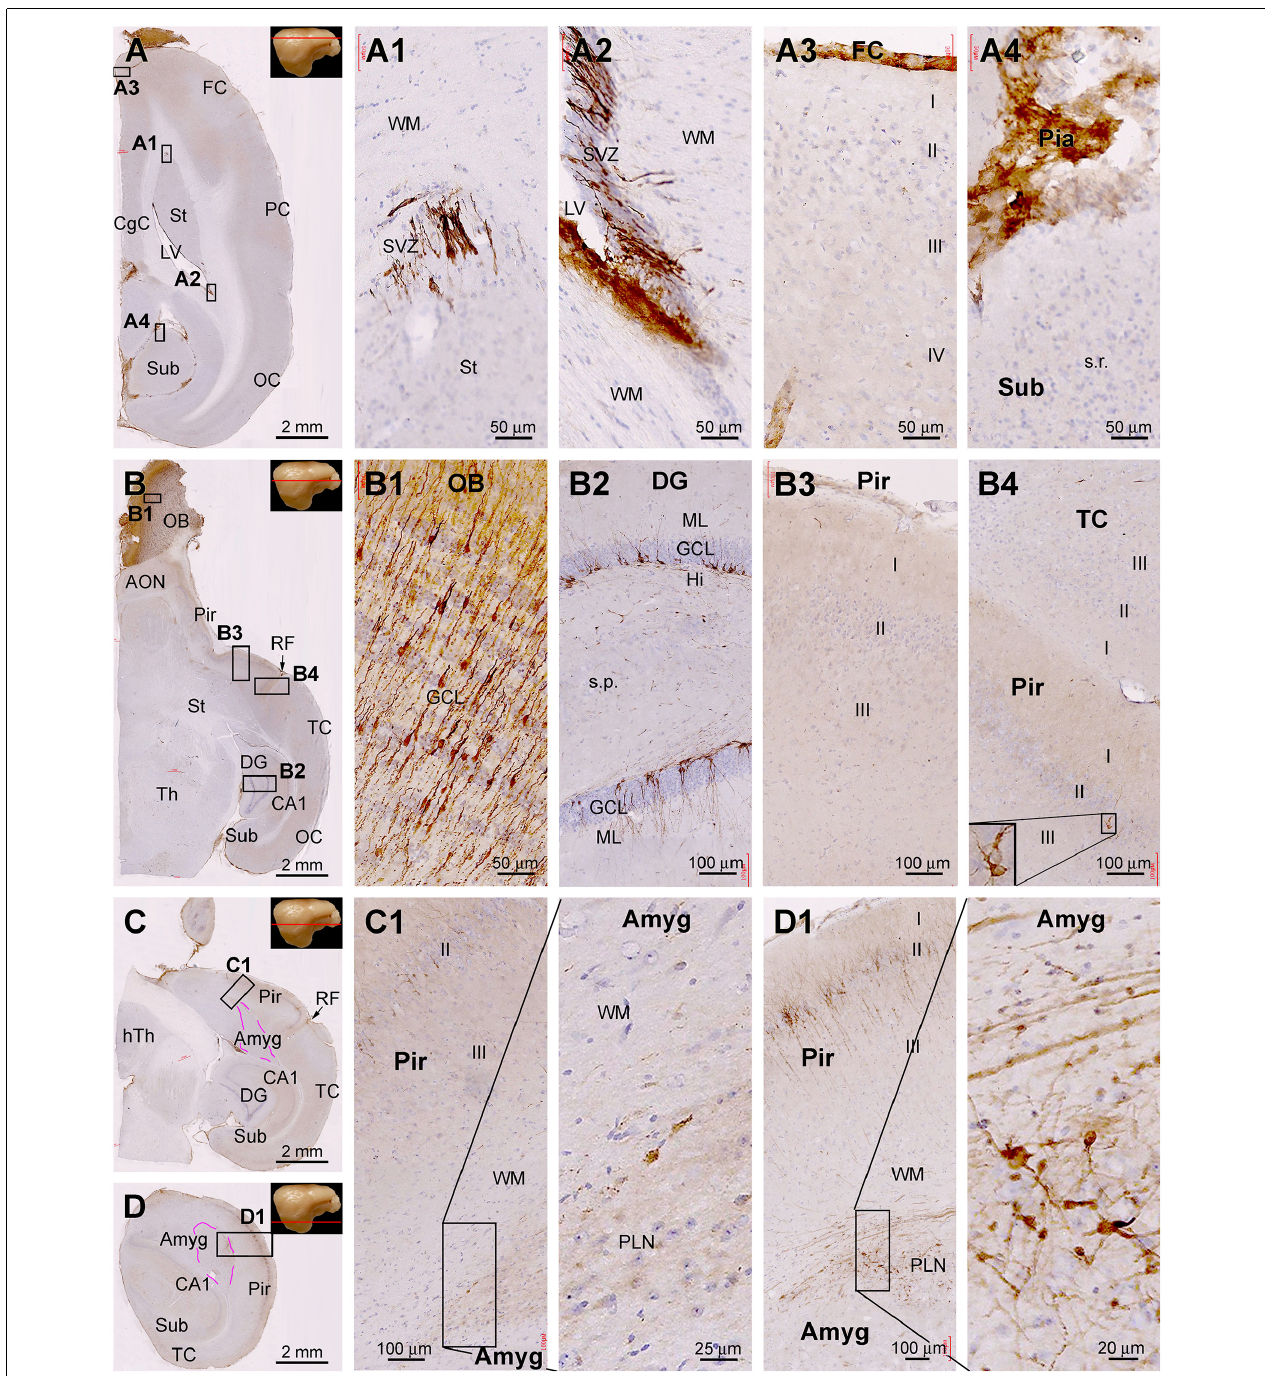
FIGURE 9 | Topographic distribution of DCX+ cellular profiles in hematoxylin-counterstained horizontal cerebral sections from a 4-year-old animal. The approximate levels of the sections relative to the lateral view of the brain are marked with a red line in the image panels. Framed areas in the low magnification panels are enlarged as indicated. The area of the amygdalar complex (Amyg) is marked with broken purple lines (C,D) . In the most dorsal level section, DCX labeling is seen at the subventricular zone lining the lateral ventricle surrounded by the stratum (St) and cingulate cortex (CgC) (A,A1,A2) . There are no DCX+ cells in the frontal neocortex (A3) and subiculum (A4) , with no specific labeling likely related to the meninge (A3,A4) . In the section at the level of the olfactory bulb (B) , DCX+ cells are found across the granule cell layer of the bulb (B1) , the subgranular zone of the dentate gyrus (B2) . Note that in the piriform cortex (Pir), no DCX+ cells are found in the rostral segment (B3) , while a few cells are present in the caudal segment near the rhinal fissure (RF) (B4) . At the basal levels of the cerebrum, a large number of DCX+ cells occur in the PLN of the amygdala (C1) , while labeled cells are also abundantly present over layer II in the Pir (D1) . Additional abbreviations are as defined in Figure 8 . Scale bars are as